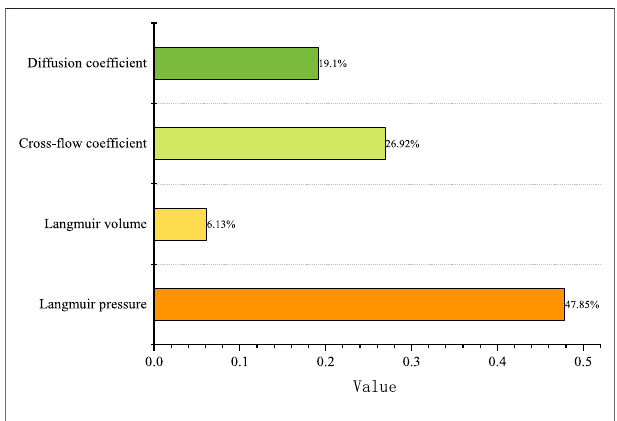
FIGURE 10 | Range analysis of geological sensitivity parameters.